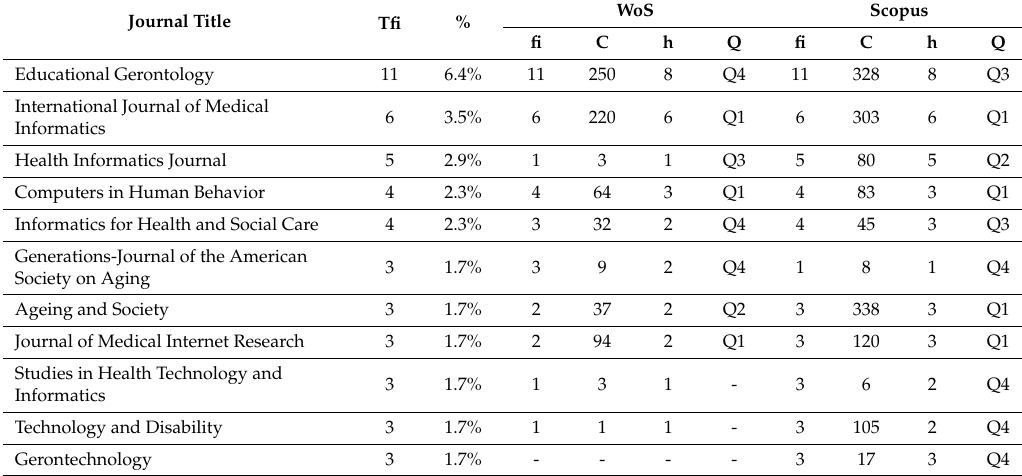
Table 5. Most productive